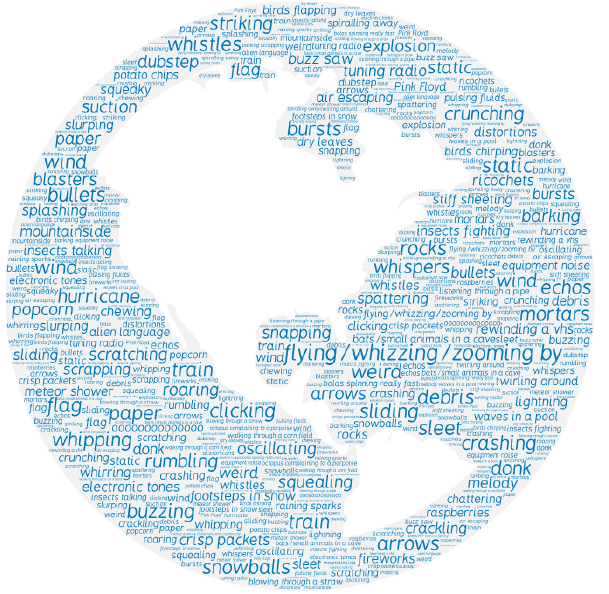
Figure 1. Word cloud of comments on what space “sounds like” from SoundCloud playlist of space